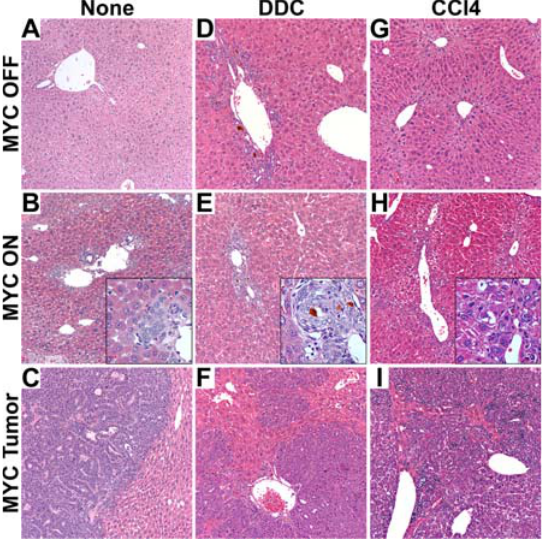
Figure 4. Hepatotoxins Induce Liver Toxicity and Cooperate with MYC to Induce Diffuse HCC’s Arising from Periportal Areas. (A) Histology of a normal adult liver. (B) Histology of a MYC- induced microcarcinoma that developed in a periportal area of the liver. Inner panel is a magnified view of the microcarcinoma. (C) Histology of a MYC-induced, multifocal adult liver tumor. (D) Histology of an adult liver 3 w after continuous DDC treatment. The liver lobule exhibits oval cell expansion radiating from the periportal area, typical of DDC- induced injury. (E) Histology of a MYC and DDC-induced microcarci- noma that stems from the periportal area. Inner panel is a magnified view of the microcarcinoma. (F) Histology of a MYC and DDC-induced diffuse liver tumor. (G) Histology of an adult liver after 4 weeks of continuous CCl 4 treatment. Microvesicular lipidosis can be seen in the centrilobular area of the liver lobule. (H) Histology of a MYC and CCl4- induced microcarcinoma that stems from the periportal area. Inner panel is a magnified view of the microcarcinoma. (I) Histology of a MYC and CCl 4 -induced diffuse liver tumor. Representative data is shown.